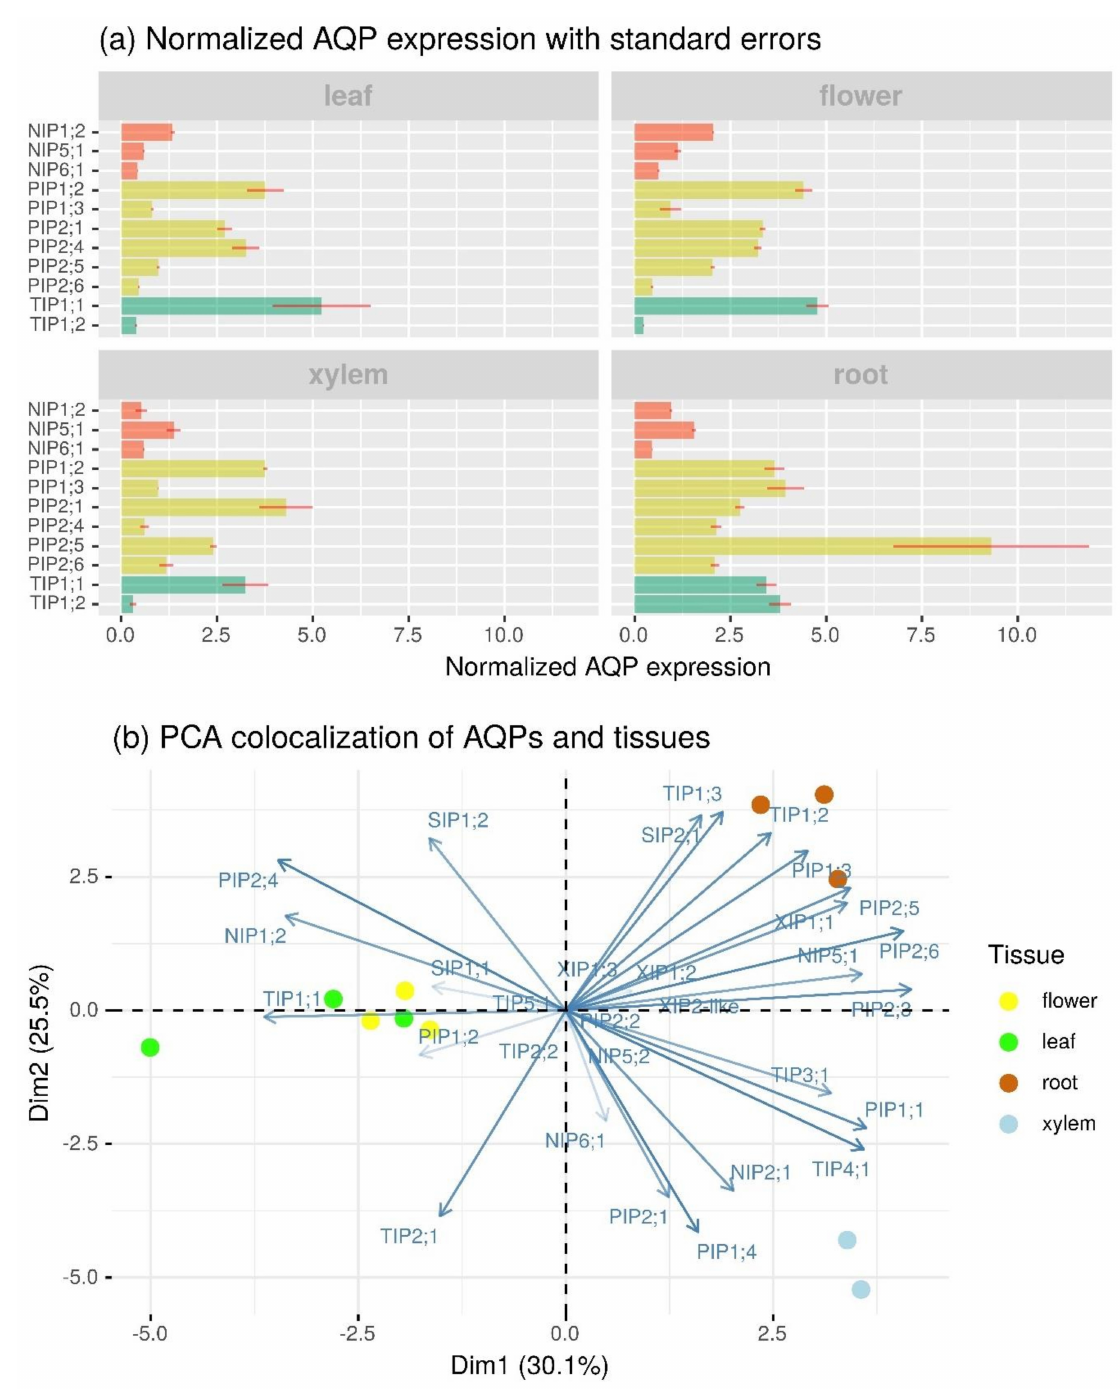
Figure 4. Organ-specific expression profiles of the BpeAQP genes from Betula pendula . ( a ) Normalized AQPs expression per organ type. Error bars are based on standard error of the mean. The Bpe AQPs are color-coded by subfamily. ( b ) PCA biplot based on the Bpe AQP expression levels and organ types. The organs are color-coded as per the legend indicated on the graph. The plane represents 55.6% of the total variance analyzed. PIP, plasma intrinsic protein; TIP, tonoplast intrinsic protein; XIP, X -intrinsic protein; NIP, nodulin-like intrinsic protein; SIP, small basic intrinsic